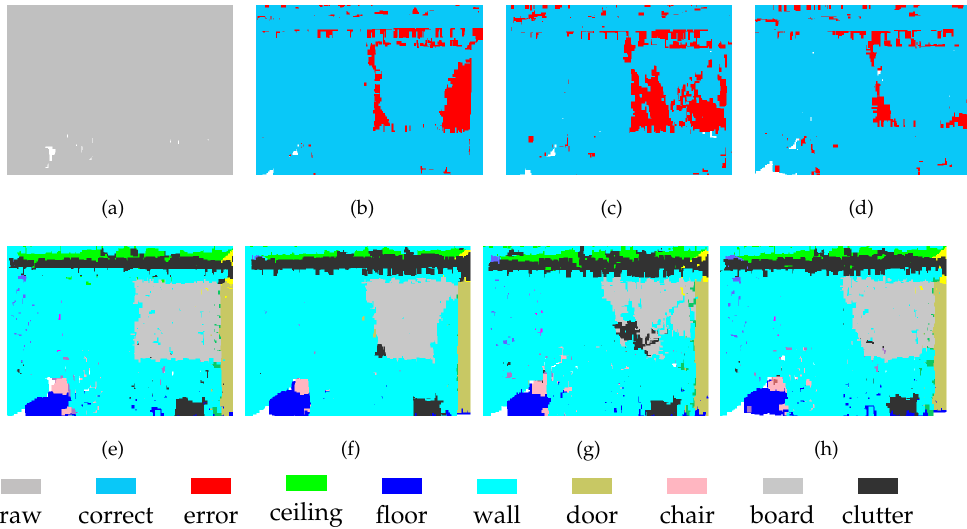
Figure 7. Segmentation results on the S3DIS-4 dataset: ( a ) input, ( e ) ground truth, ( b , f ) Level-1, ( c , g ) Level-2, and ( d , h )